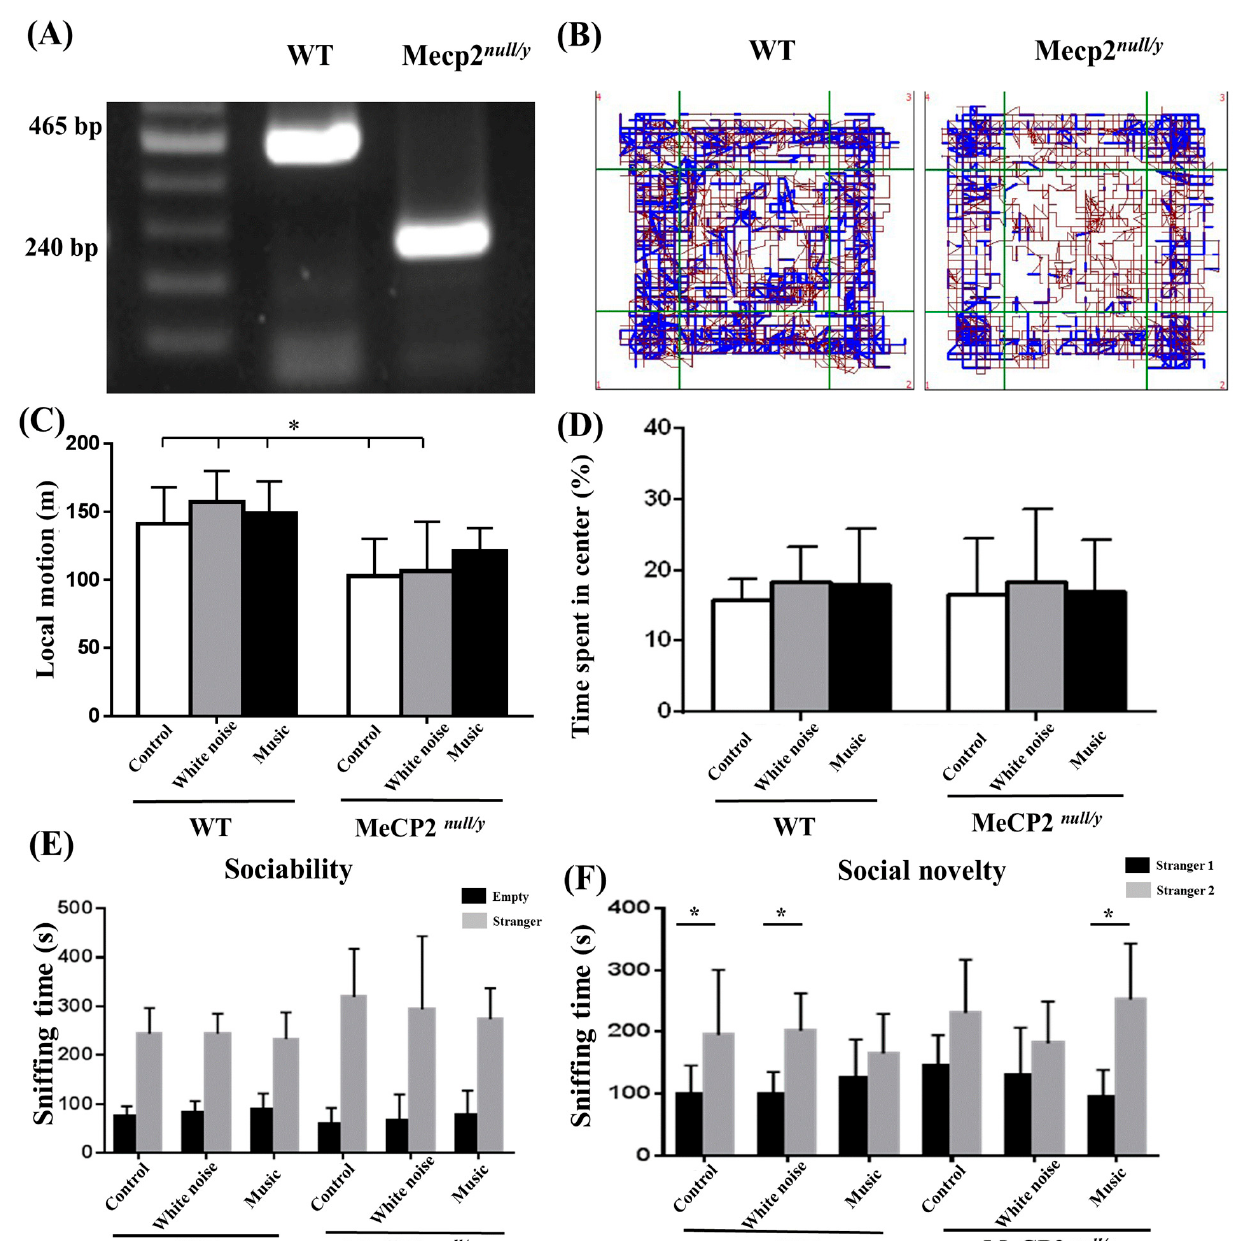
Figure 1. Motor function and anxiety-related behaviors tested in the open field and social ability tested with three-chamber social ability and social novelty measurements. ( A ) Genomic tail DNA was prepared for all animals before the experiment. ( B ) The representative movement tracks of wild-type mice (left) and mecp2 null/y mice (right) in the open field are shown. ( C ) The traveling distances were significantly lower for C- mecp2 null/y and W- mecp2 null/y mice as compared with all wild-type mice. ( D ) The pecentage of time spent in the central zone was comparable for mecp2 null/y and wild-type mice. ( E ) No significant differences in the sniffing of stranger mice between Mecp2 null/y and wild-type mice were identified in the social ability test. ( F ) The M- mecp2 null/y mice spent more time sniffing novel mice as compared with the C- mecp2 null/y mice. (* p < 0.05).